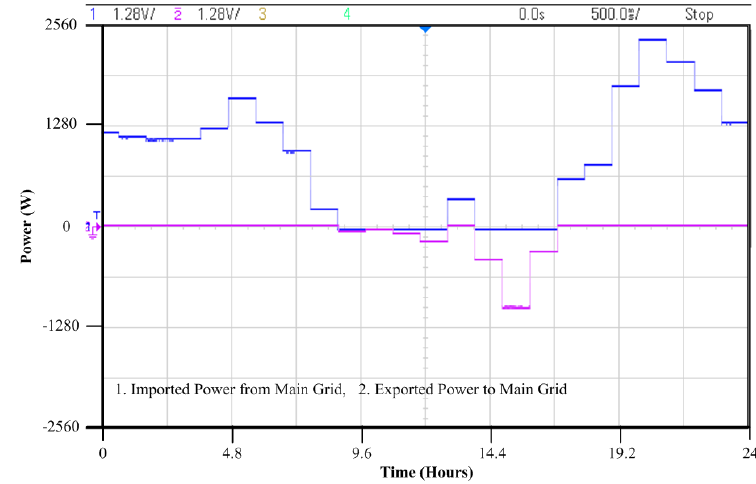
Figure 17. Grid power for scenario-3.